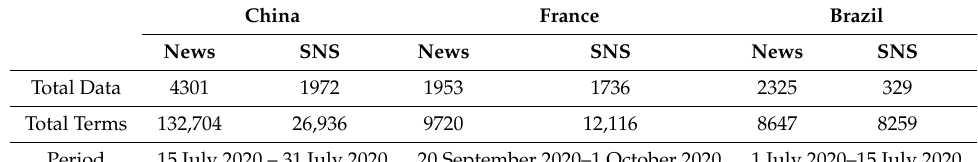
Figure 6. Daily time-series number of COVID-19-related data for Korea. Table 3. Data used for the event detection capability experiment of WBiLSTM-TF-IDF.